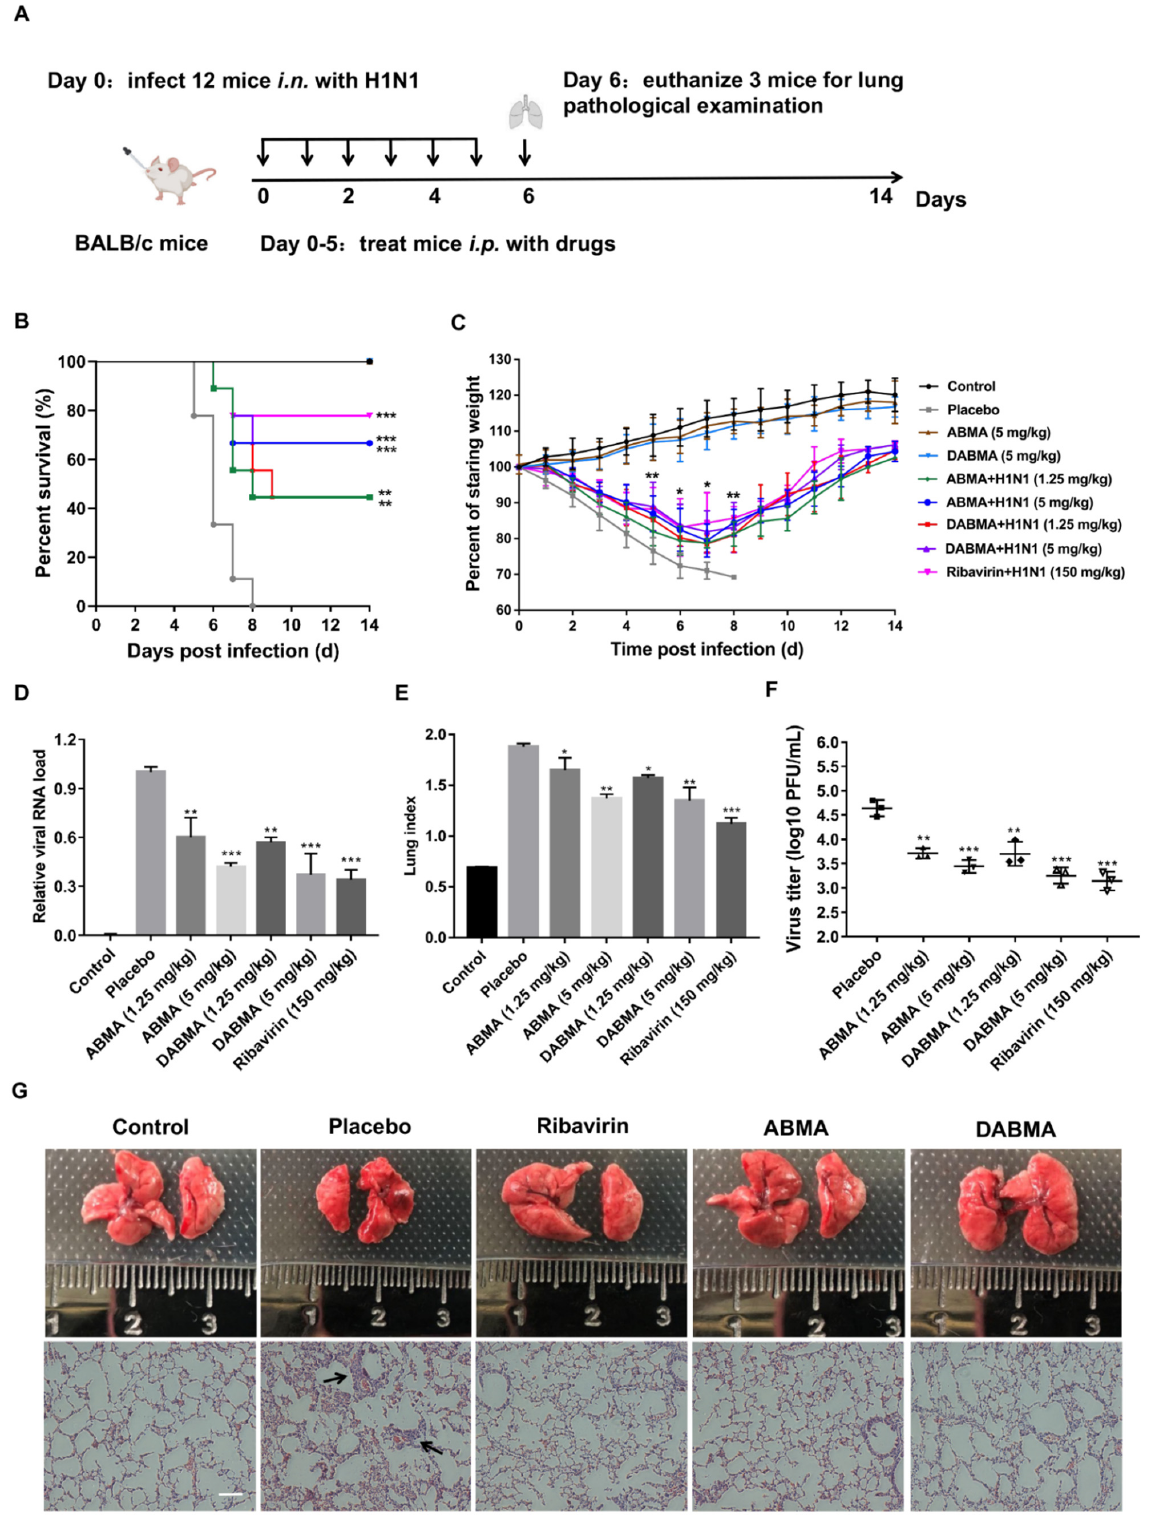
Figure 6. Evaluation of the therapeutic efficacy of ABMA and DABMA in H1N1 inoculated mice. ( A ) BALB/c mice were mock-infected or infected with H1N1 (1 × 10 9 EID 50 /50 µ L) and were injected intraperitoneally with the different compounds once a day for six consecutive days. Survival rate ( B ) and body weight ( C ) of the mice ( n = 9) were recorded daily for 14 days. Three additional mice